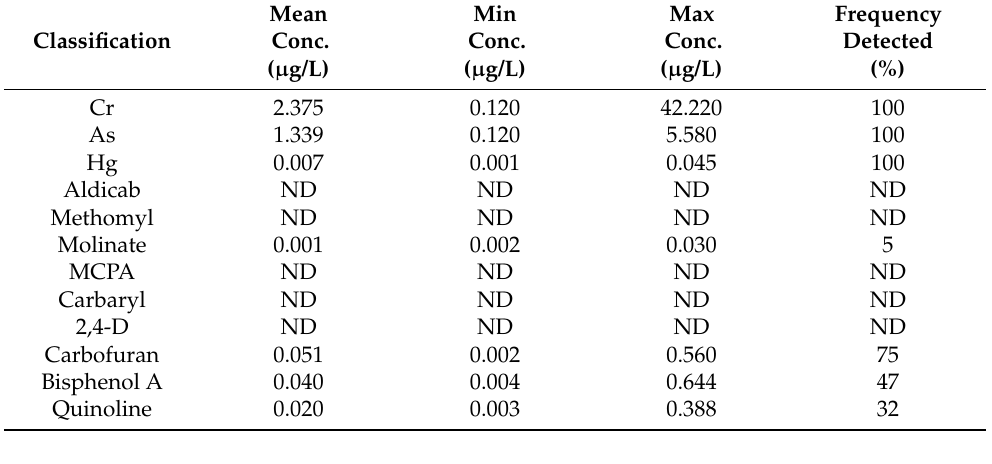
Table 1. Summary statistics for target compounds detected in tributaries of the Han River watershed.